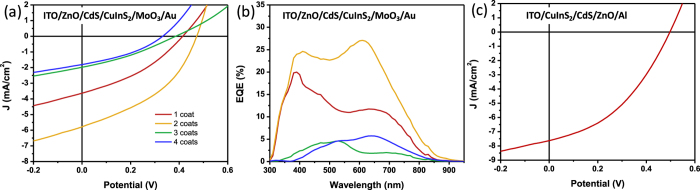
Solar cell characteristics.(a) J-V characteristics and (b) EQE spectra of CuInS2 solar cells prepared on ZnO/CdS substrates. (c) J-V characteristics of solar cells prepared on ITO substrates.